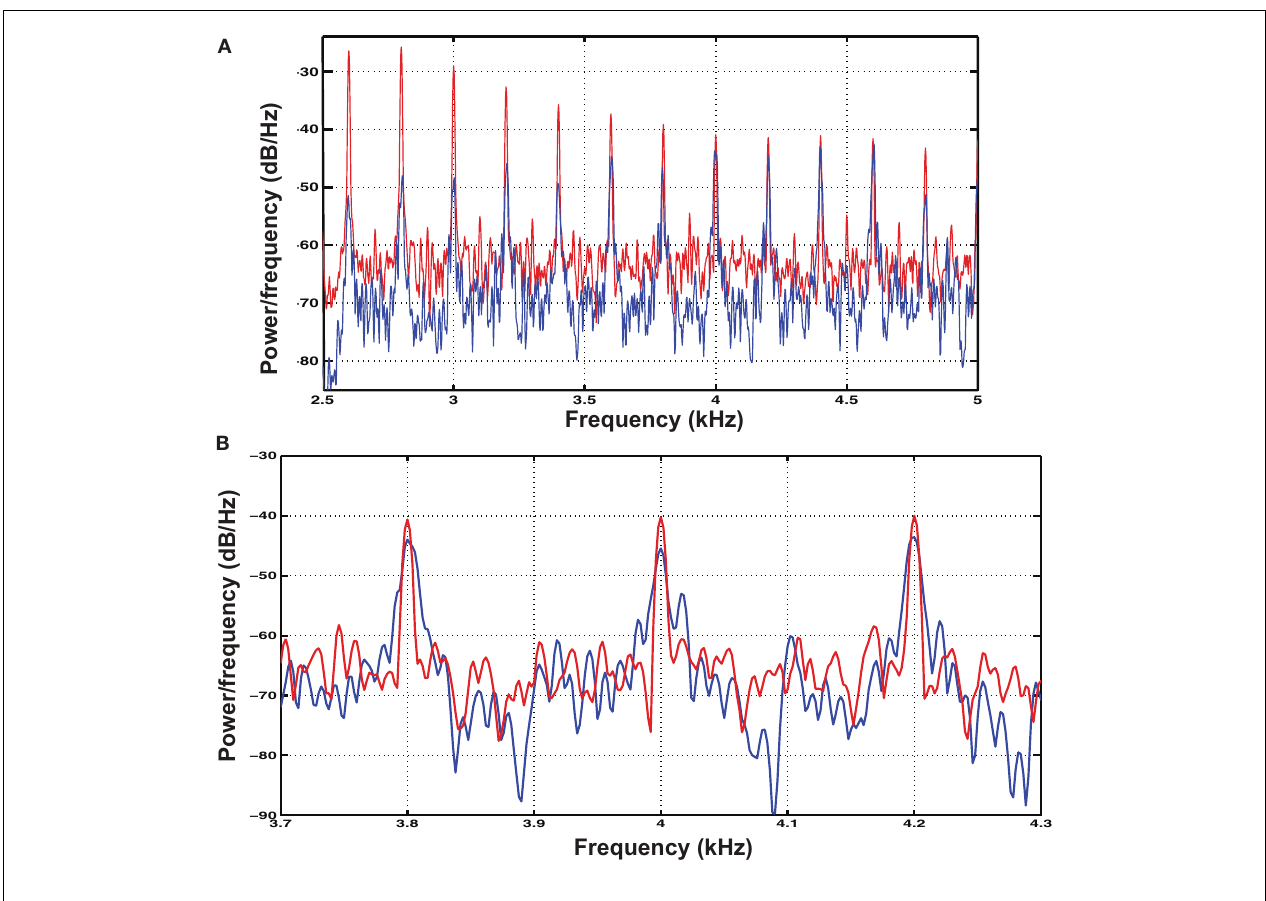
FIGURE 2 | (A) Shows the power spectra calculated usingWelch’s method for the IRN (blue) and complex harmonic (red) 200Hz stimuli used in the experiment.The spectra were calculated with a 11025-point Hamming window applied with a 10925-point overlap. (B) Shows a zoomed-in view of three of the upper harmonics of the stimuli, illustrating the difference